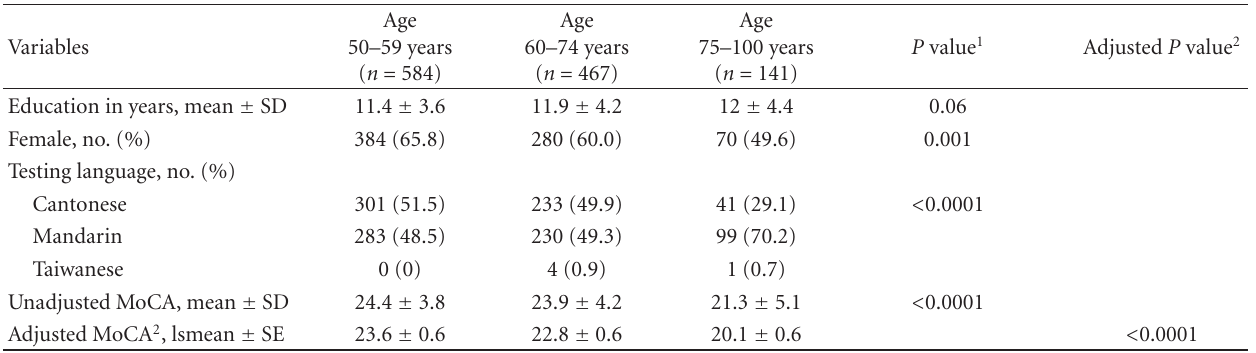
Table 4: Comparison of education, gender, test language, and MoCA-ChLA score among the three age groups.